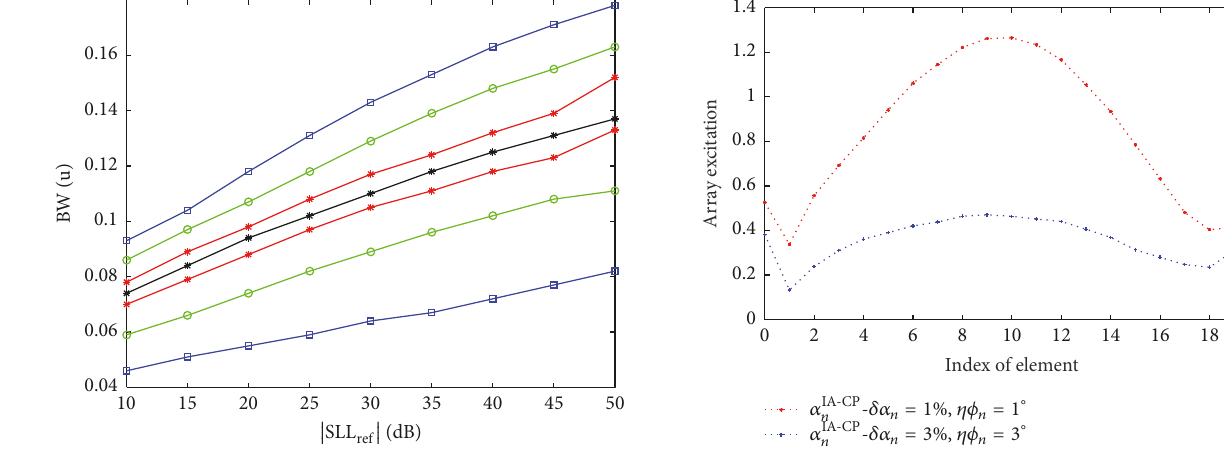
Figure 7: Optimized array excitation amplitudes using IA-CP method.